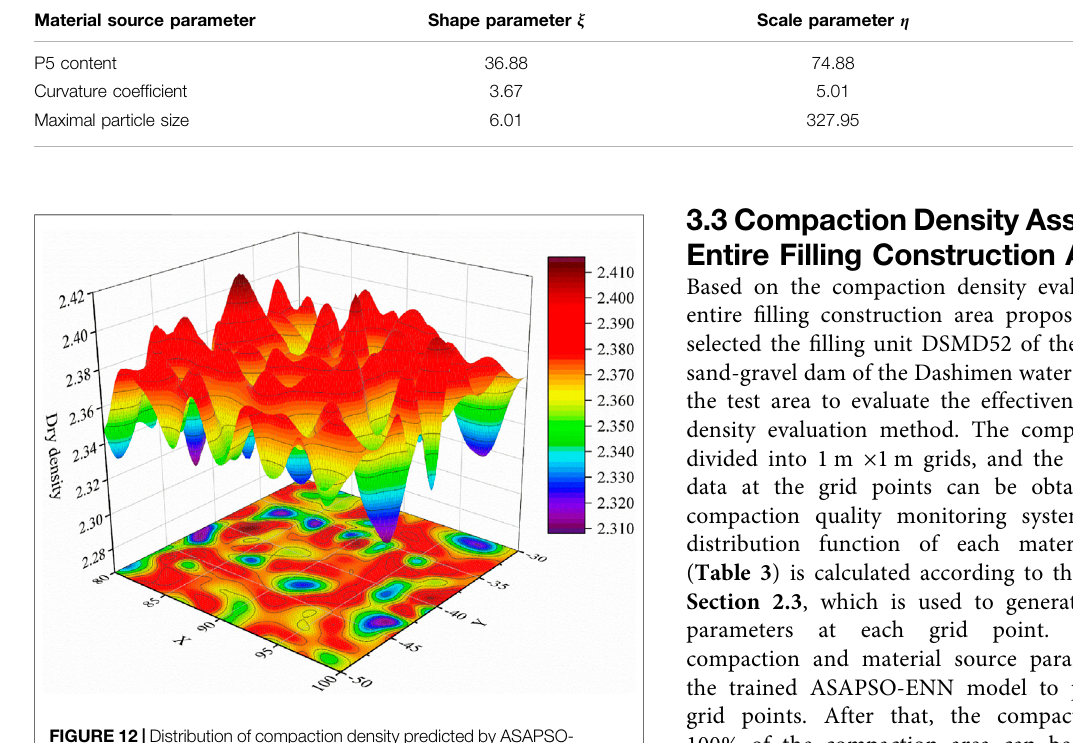
TABLE 3 | Distribution function of material source parameters.